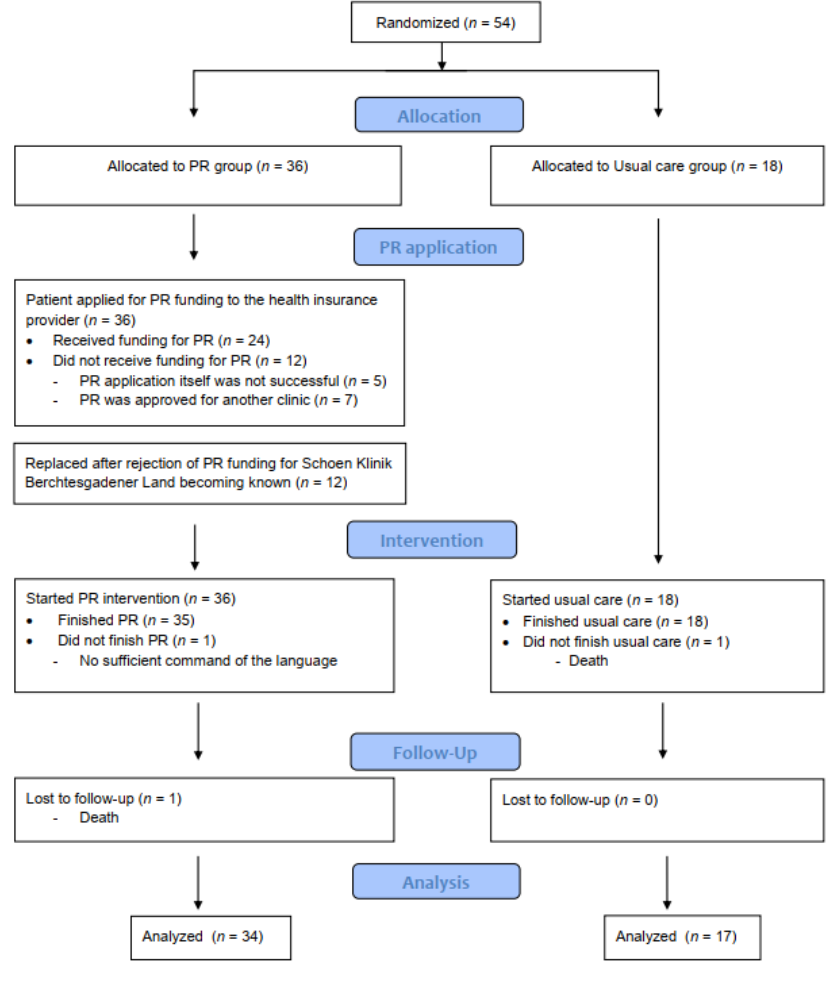
Figure 1. Flow diagram.